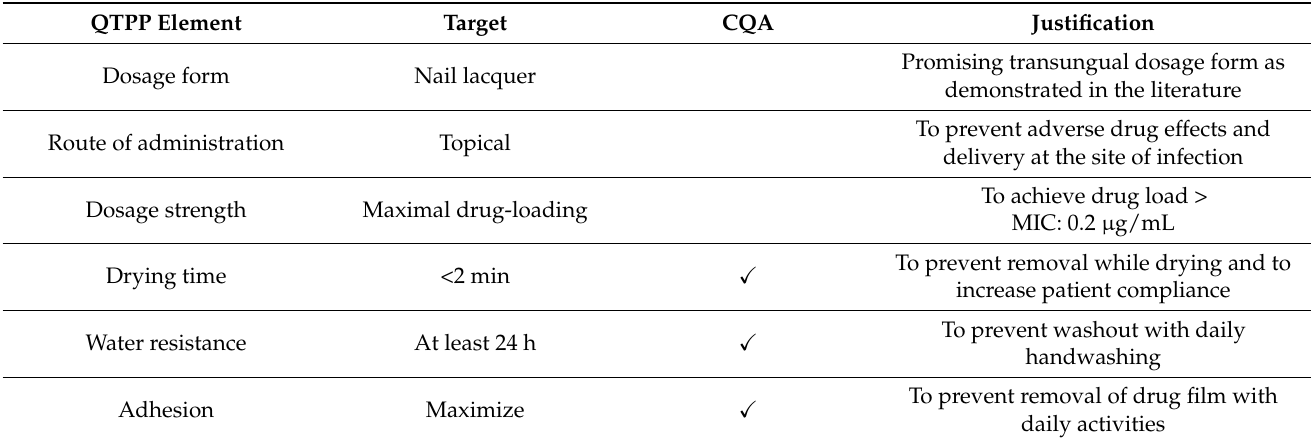
Table 4. Quality target product profile (QTPP) for antifungal nail